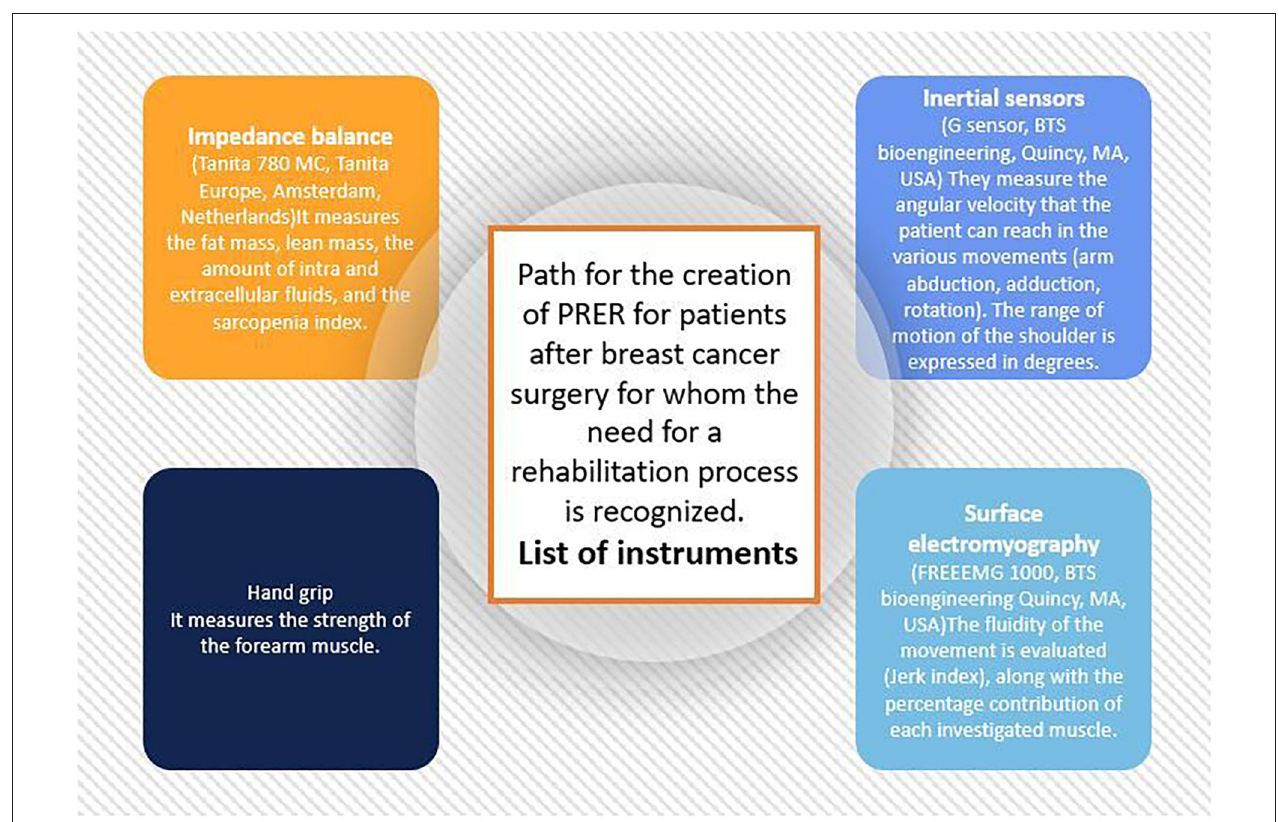
FIGURE 2 | Path for the creation of PRER for patients after breast surgery for whom the need for a rehabilitation process is